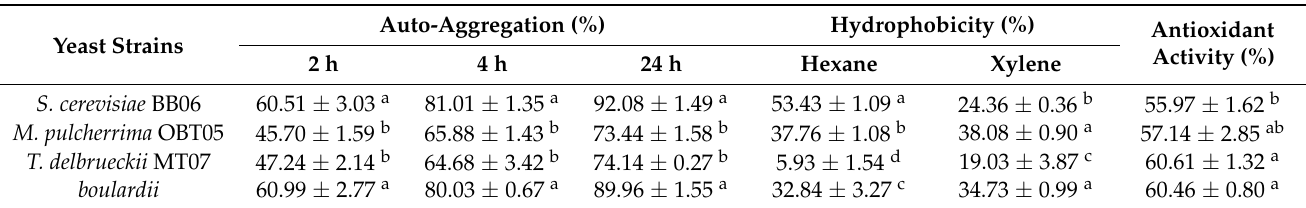
Results are represented as mean ± SDs of three independent experiments. Significant statistical differences Table 1. Summarized characteristics and properties of yeast strains: auto-aggregation ability, ( p < 0.05) between yeast strains according to the Tukey B test from one-way analysis of variance (ANOVA) have been indicated by different hydrophobicity, and antioxidant activity.